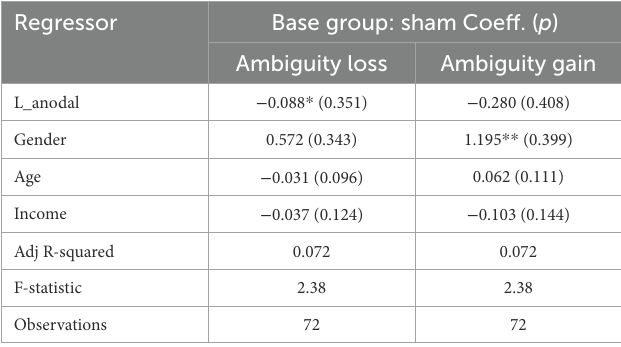
TABLE 2 The coefficients and significance of left DLPFC tDCS in the regression